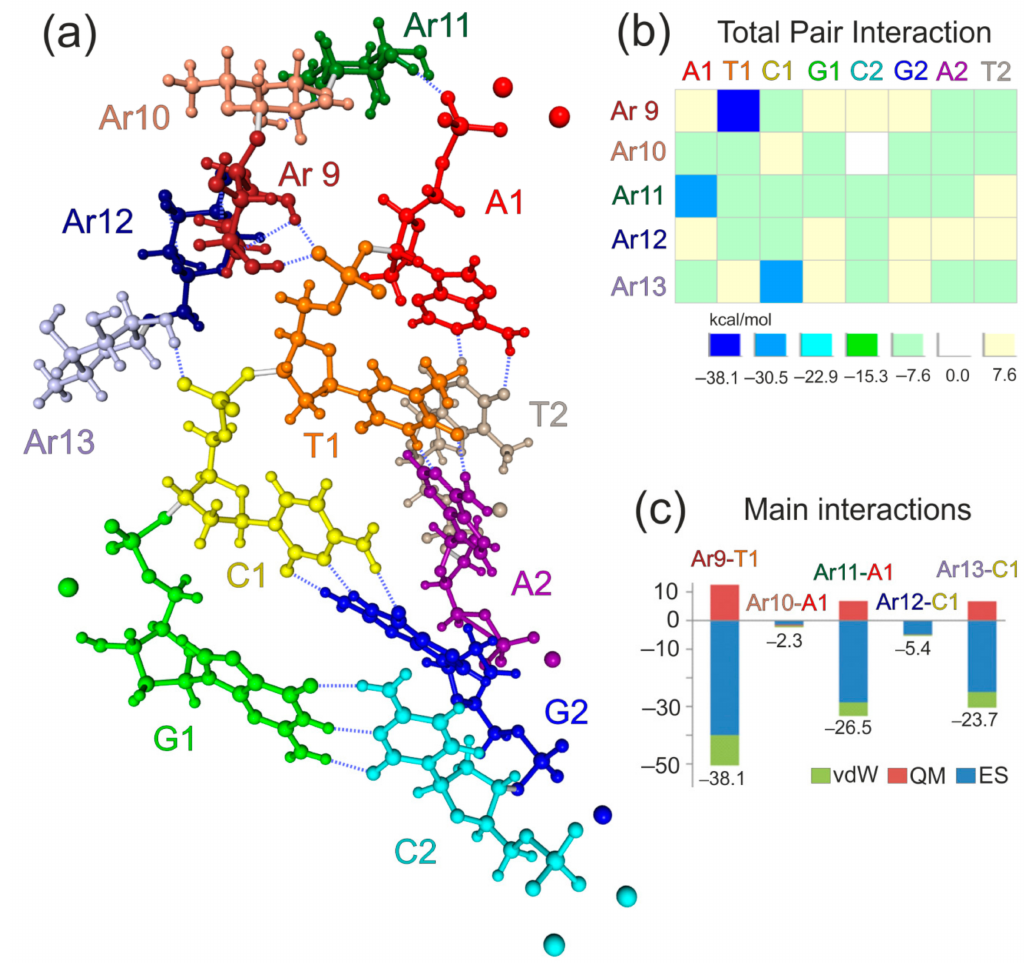
Figure 3. The molecular structure and results of the fragment molecular orbital method (FMO) applied to the aptamer-arabinogalactan complex. ( a ) Fragments of arabinogalactan and aptamer AS-14 are shown in di ff erent colours. ( b ) Total pair interactions between arabinogalactan (Ar9–Ar13) and aptamer fragments (A1, T1, C1, G1, A2, T2, C2, G2,). All values are in kcal / mol. ( c ) Main interactions between arabinogalactan (Ar9–Ar13) and aptamer fragments (T1, A1, C1). The total values are shown below each bar. All values are in kcal / mol. Each pair interaction is divided into electrostatic (ES), quantum-mechanical (QM), and van-der-Waals (vdW)